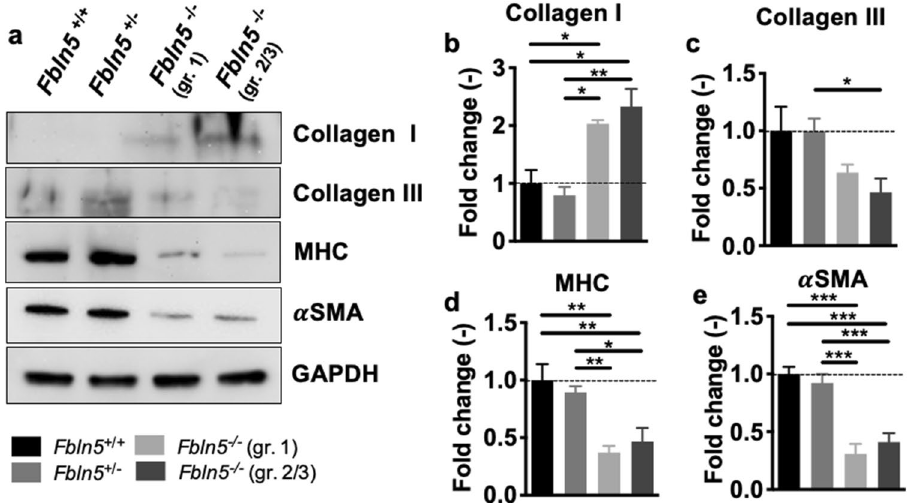
Figure 8. Western blotting analysis for collagens and smooth muscle cell contractile proteins. Representative cropped western blot displaying expression of collagens and smooth muscle proteins ( a ). Cropped blots displayed with full-length western blots reported in Supplementary Figs. S7-13. Densiometric analysis for protein expression of collagen type I ( b ) and collagen type III ( c ) in the Fbln5 +/+ (black; n = 6), Fbln5 +/− (grey; n = 6), Fbln5 -/- with grade 1 POP (light grey; n = 6), and Fbln5 -/- with grade 2/3 POP (dark grey; n = 6) vaginas. Fibulin-5 insufficiency and POP significantly affected collagen type I (p = 0.001) and collagen type III (p = 0.02) protein expression. Collagen type I protein expression increased in the Fbln5 −/− vagina with grade 1 (p = 0.03) and 2/3 (p = 0.01) POP compared to the Fbln5 + / + . Collagen type I protein expression increased in the Fbln5 −/− vagina with grade 1 (p = 0.01) and 2/3 (p = 0.008) POP compared to the Fbln5 +/− . Collagen type III protein expression decreased in the Fbln5 −/− vagina with grade 2/3 POP (p = 0.02) compared to the Fbln5 +/− . Densiometric analysis for protein expression of myosin heavy chain ( d ; MHC) and alpha-smooth muscle actin (e; αSMA). Fibulin-5 insufficiency and POP significantly affected (p < 0.001) MHC and αSMA protein expression. MHC protein expression decreased in the Fbln5 −/− vagina with grade 1 (p = 0.001) and 2/3 (p = 0.006) POP compared to the Fbln5 + / + . MHC protein expression decreased in the Fbln5 −/− vagina with grade 1 (p = 0.006) and 2/3 (p = 0.03) POP compared to the Fbln5 +/− . αSMA protein expression decreased (p < 0.001) in the Fbln5 −/− vagina with grade 1 and 2/3 POP compared to the Fbln5 + / + . αSMA protein expression decreased (p < 0.001) in the Fbln5 −/− vagina with grade 1 and 2/3 POP compared to the Fbln5 +/− . Protein expression levels were normalized to GAPDH. Data reported as fold change relative to Fbln5 +/+ control. Data is reported as mean ± standard error of mean. Statistical significance is denoted by *p < 0.05, **p < 0.01 and ***p <